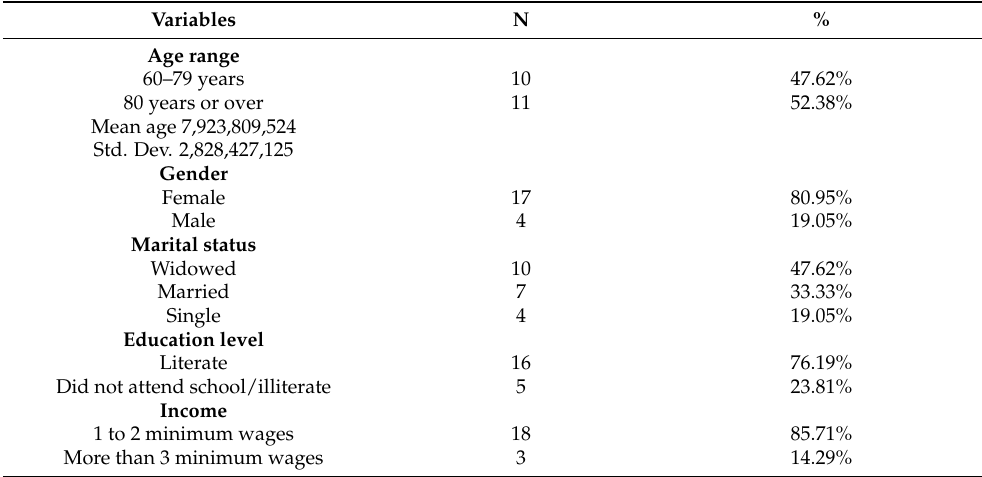
Table 1. Sociodemographic characterization of dependent older adults. Vit ó ria da Conquista/BA,